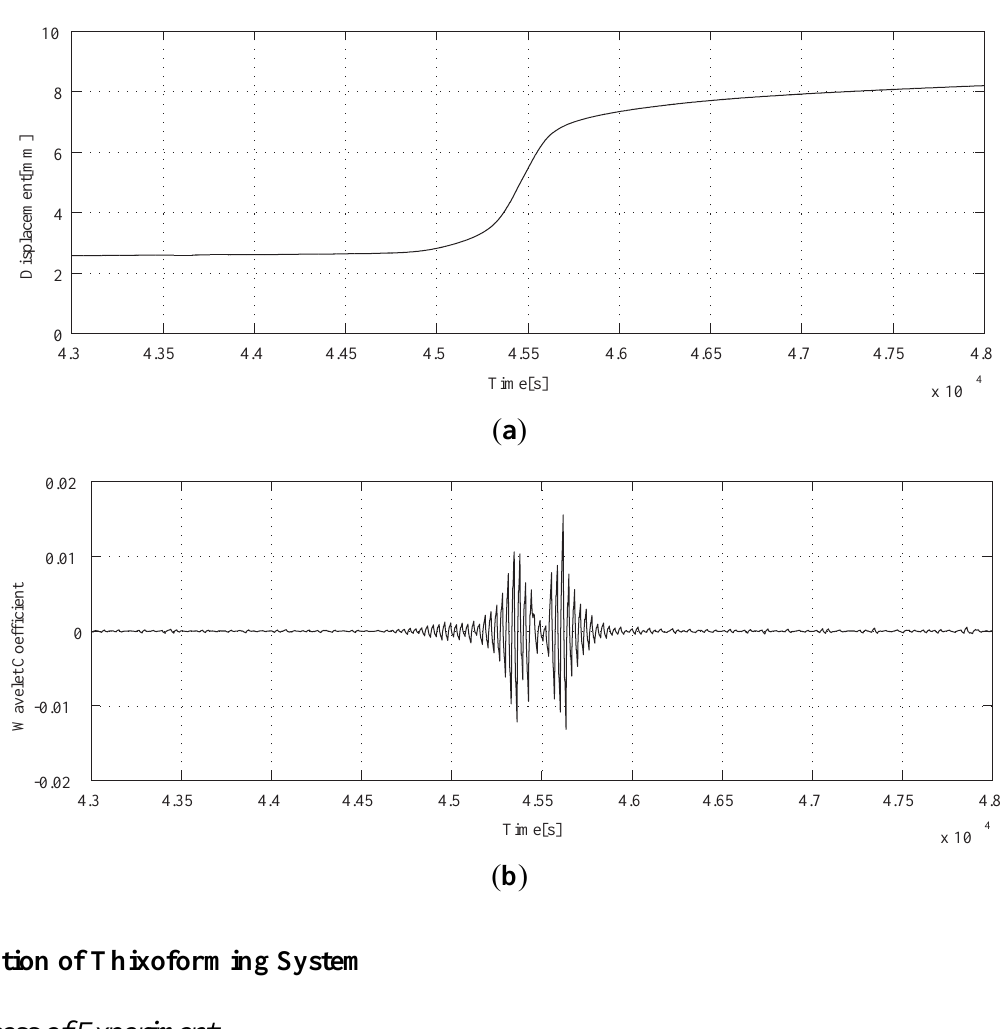
Figure 7. Result of the wavelet analysis (Daubechies). ( a ) Displacement of FGM billet; ( b ) Wavelet Coefficient to